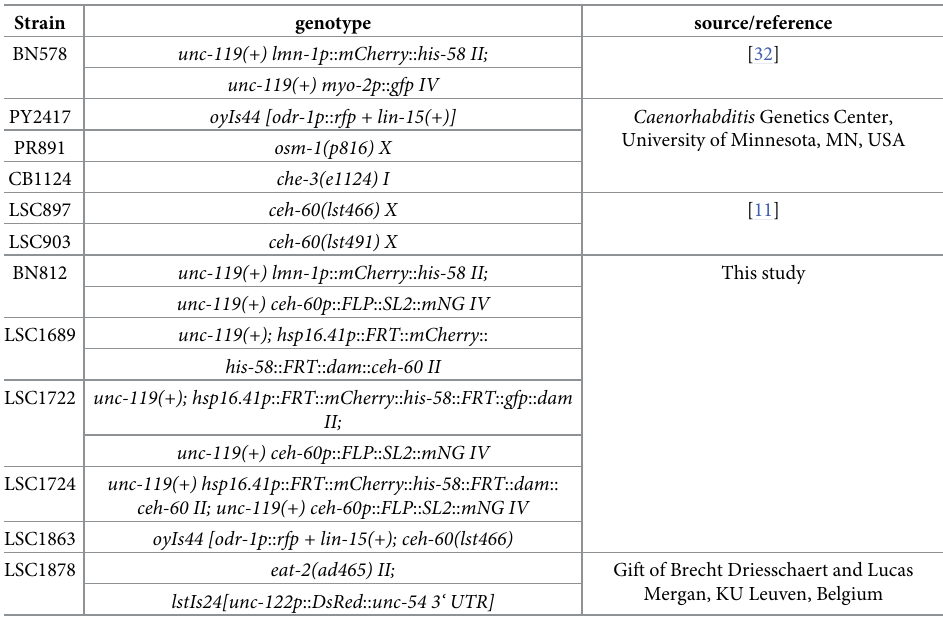
Table 1. List of C . elegans strains used, including genotype and